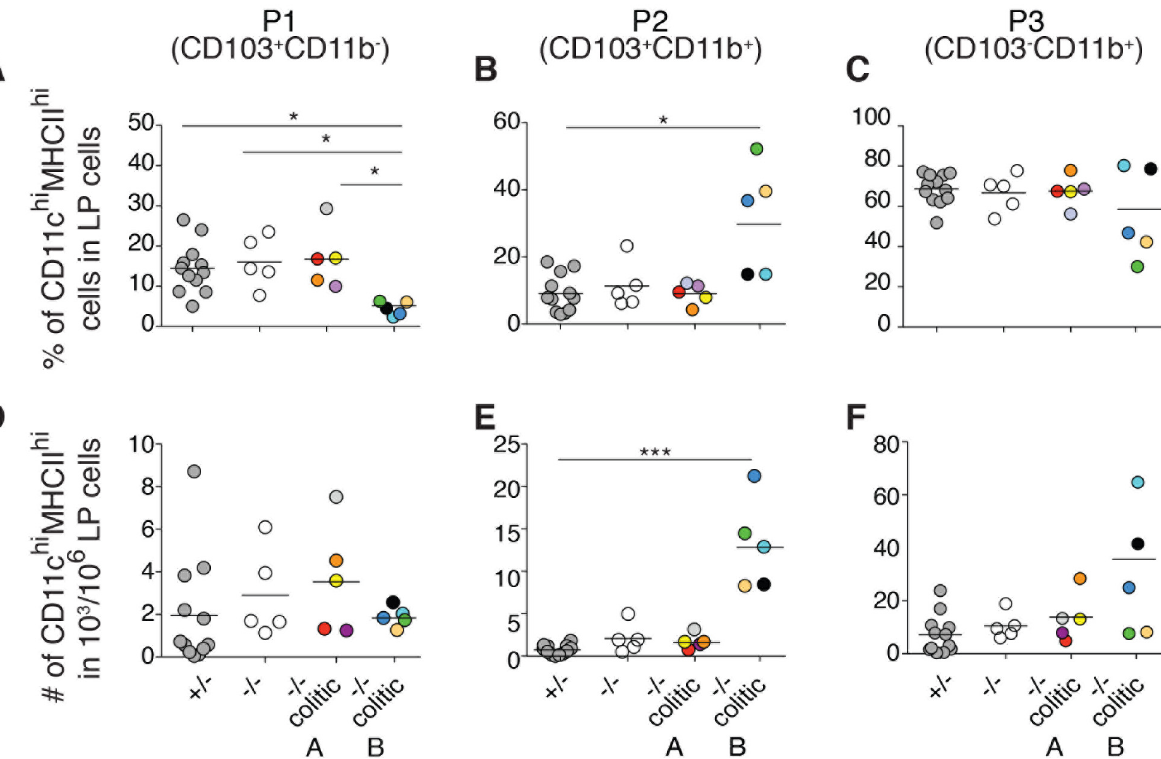
Fig 4. Cytokine profiles in the distal colon of colitic mice correlate with increased CD103 + CD11b + P2 DCs in the same colon segment. LP cells of the other half of the same distal colon segment of the same mice used for cytokine analyses in Fig 3 were analyzed by flow cytometry. Cells were gated as in Fig 2A. (A-C) The frequency of DCs belonging to subsets P1 (A), P2 (B) or P3 (C) among viable MHCII + CD11c hi cells is shown. (D-E) The absolute number of DCs belonging to subsets P1 (D), P2 (E) or P3 (F) among 10 6 viable LP cells is depicted. Each symbol represents an individual mouse and the solid line indicates the mean of each group. Statistical significance between groups was assessed using the Kruskal-Wallis test followed by Dunn ’ s multiple comparison test.